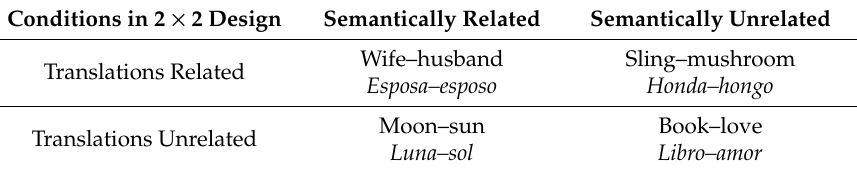
Table 1. The 2 × 2 stimuli